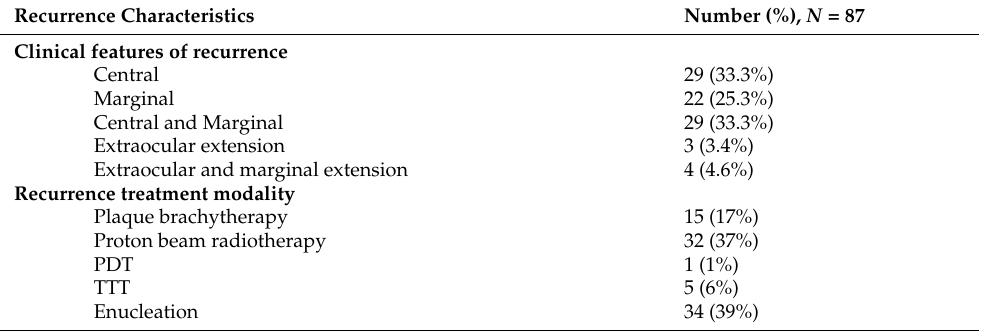
Table 2. Clinical features of recurrences together with the treatment modalities employed for their